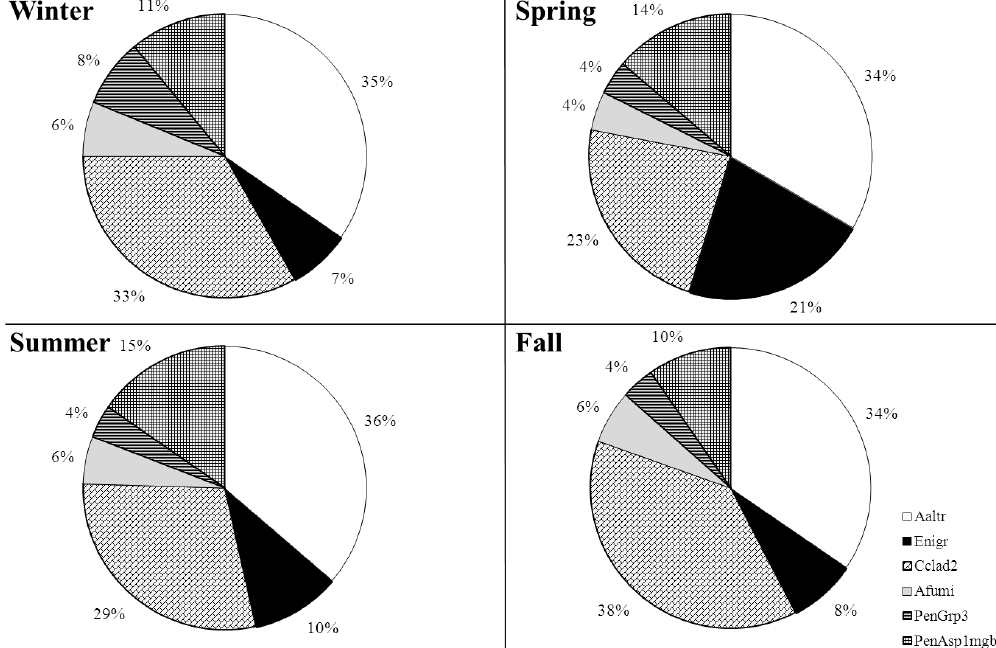
Fig. 1. Seasonal distributions of specific fungi species detected in sampled filters by q-PCR analysis (represented by the specific detection Figure 1. 497 assays). The values represent the relative abundance out of the sum of the specific fungi considered.